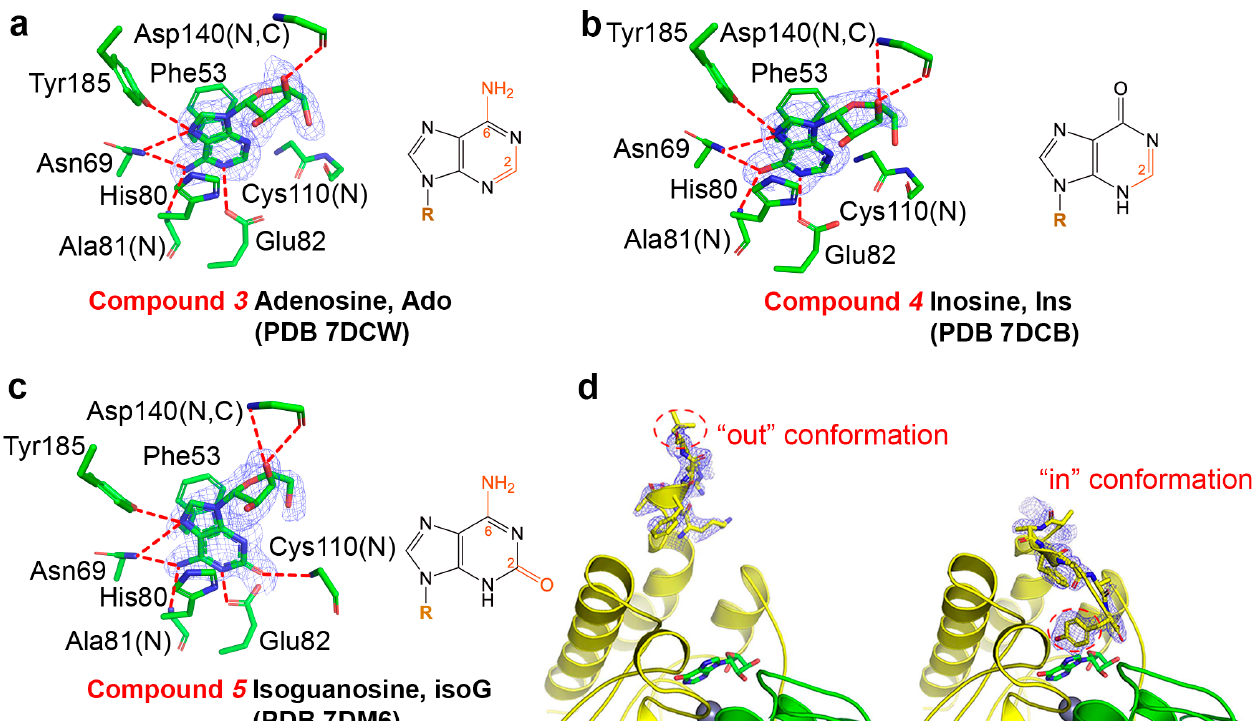
Figure 3. The inhibition modes of compounds 3 – 5. ( a – c ) The omit electron density maps showing the interactions with the inhibitor adenosine ( a ), inosine ( b ), and isoguanosine ( c ). The maps are contoured at 3 σ and only the more tightly bound ligands are shown. The chemical structures of the ligands are drawn with their unique parts in red. G: guanine; R: ribose. ( d ) The two possible conformations of the C-terminus observed in the WT-inosine complex (PDB 7DCB). The two chains are shown in ribbon representation and colored green and yellow, respectively. The spheres indicate the catalytic zinc ions. Note that in the final model, the “in” conformation (also the major conformation) is modeled.